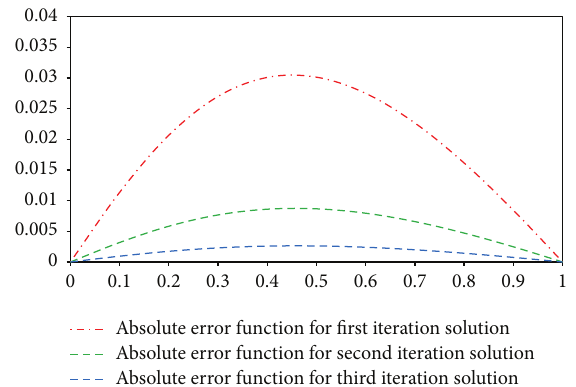
Figure 7: Comparison of the absolute error functions of the first three iteration solutions of the PIA (1, 1) method with the exact solution for example